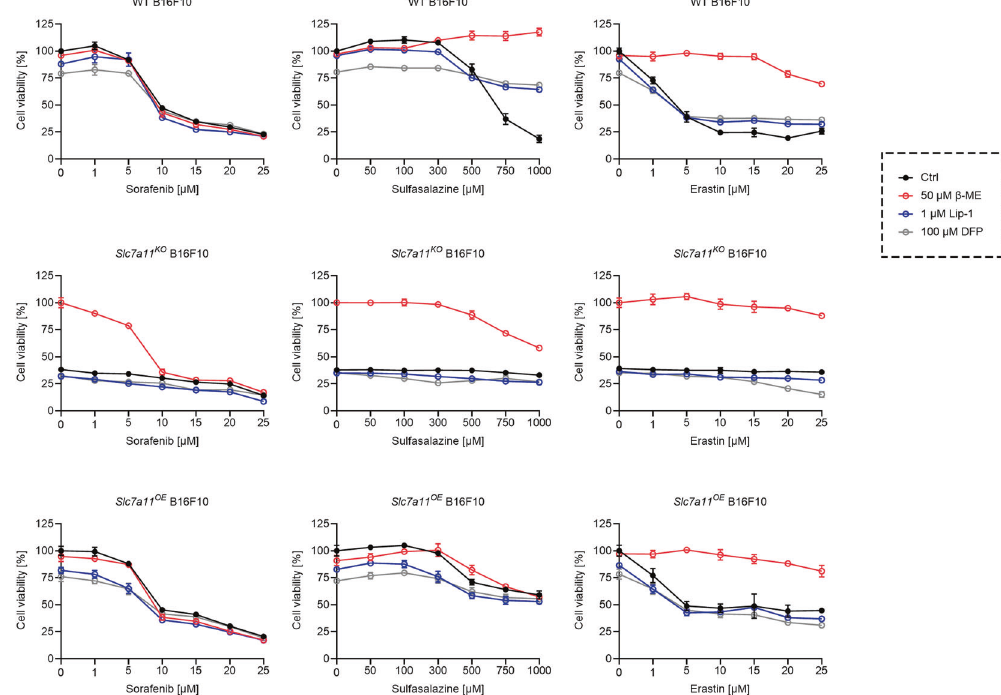
Fig. 4 Sorafenib does not induce ferroptosis in B16F10 cells. Cell viability of WT, Slc7a11 KO , and Slc7a11 OE B16F10 cells treated with indicated concentrations of sorafenib, sulfasalazine, or erastin, in the absence or presence of 50 μ M β -ME, 1 μ M Lip-1, or 100 μ M DFP for 24 h. Data are presented as mean ± s.d. of n = 3 wells of a 96-well plate from one representative of three independent